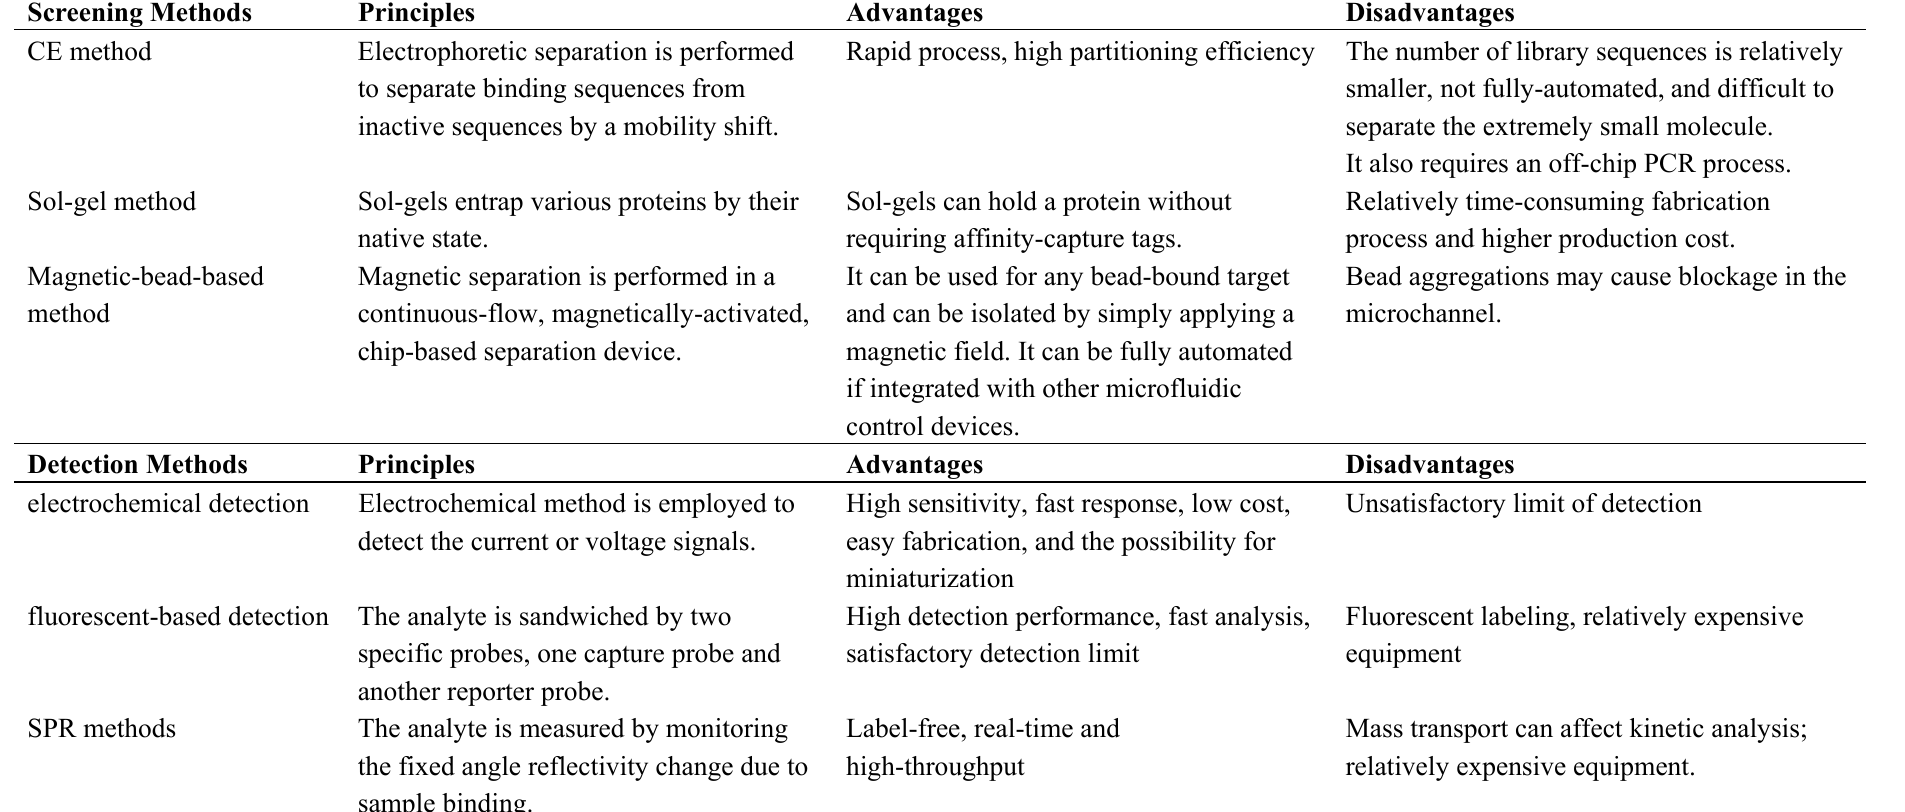
Table 1. Summary for screening methods and detection methods in microfluidic